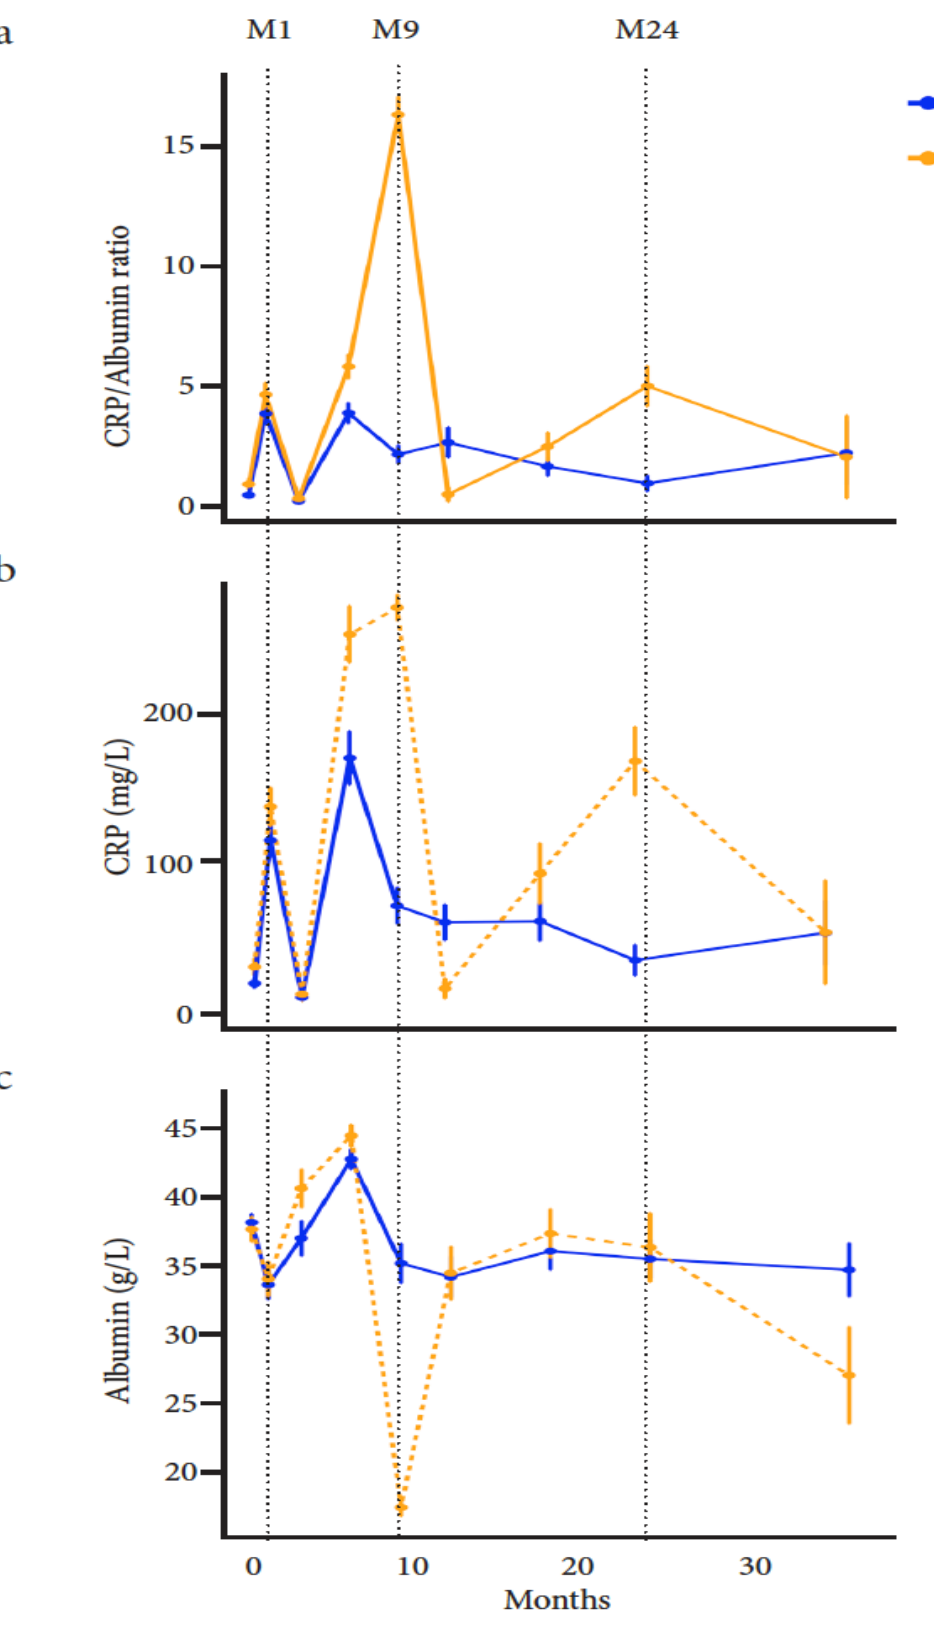
Figure 1. ( a ): Longitudinal trajectory clustering of the CAR among elderly outpatients with cancer; ( b ): longitudinal trajectory of CRP levels among elderly outpatients with cancer; ( c ): longitudinal trajectory of albumin levels among elderly outpatients with cancer.